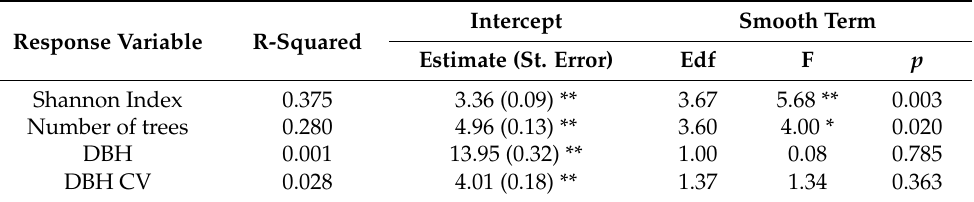
Table 2. Results of the Generalised Additive Models to explain the effect of distance from the forest edge on four vegetation parameters. The vegetation parameters are based on 33 vegetation plots at the Ampasy valley, north of the Tsitongambarika lowland rainforest, southeast Madagascar.